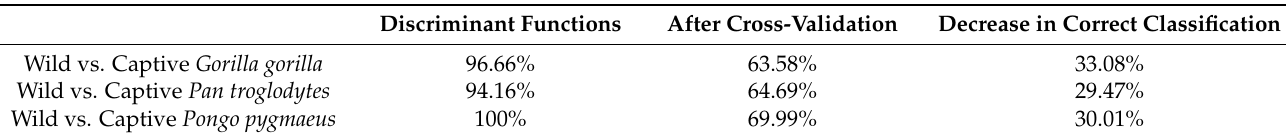
Table 3. Percentages of correct post hoc classification from the discriminant functions and after leave-one-out cross-validation, with the percentage of decrease in correct classification.